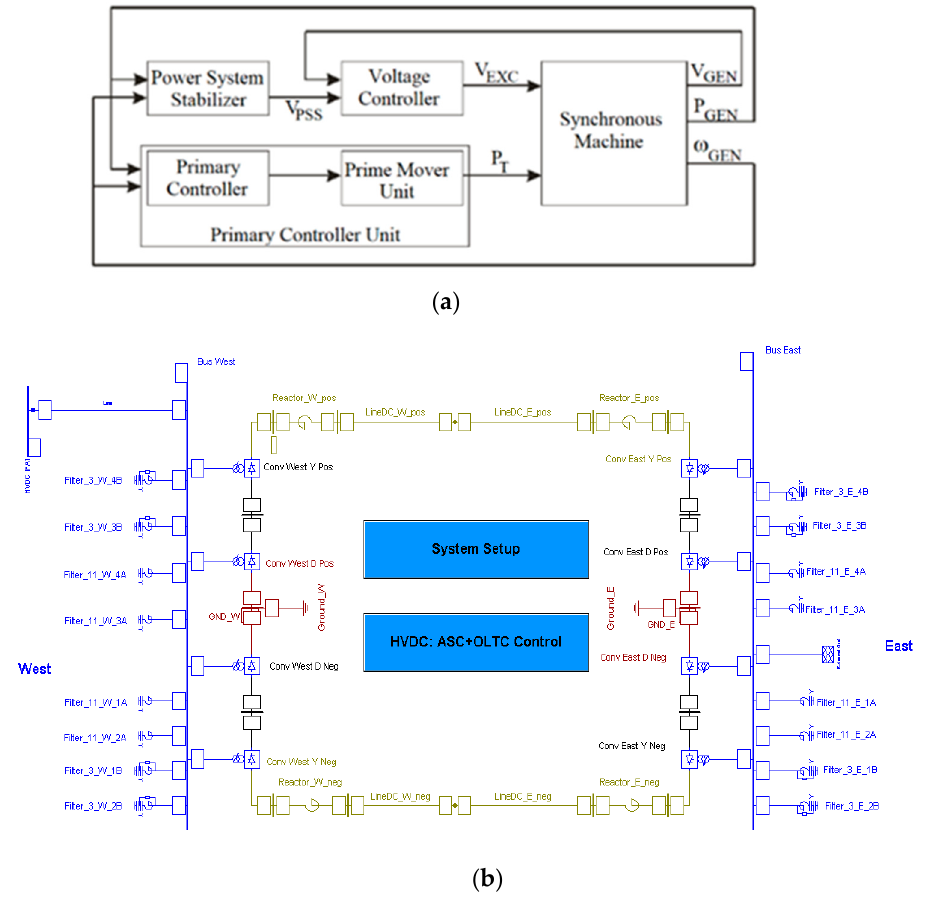
Figure 5. ( a ) PowerFactory control block for synchronous generators and ( b ) HVDC LCC model, as included in the original reduced model [23].